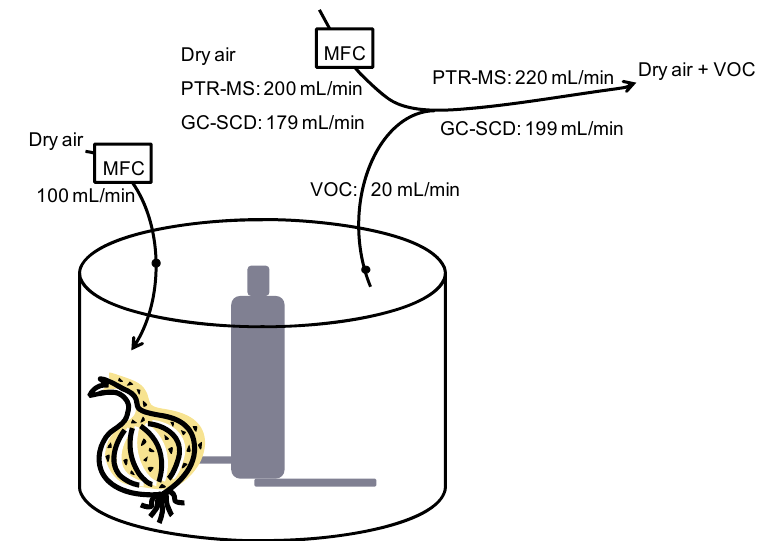
Figure 2. Experimental setup of sampling for PTR-MS or